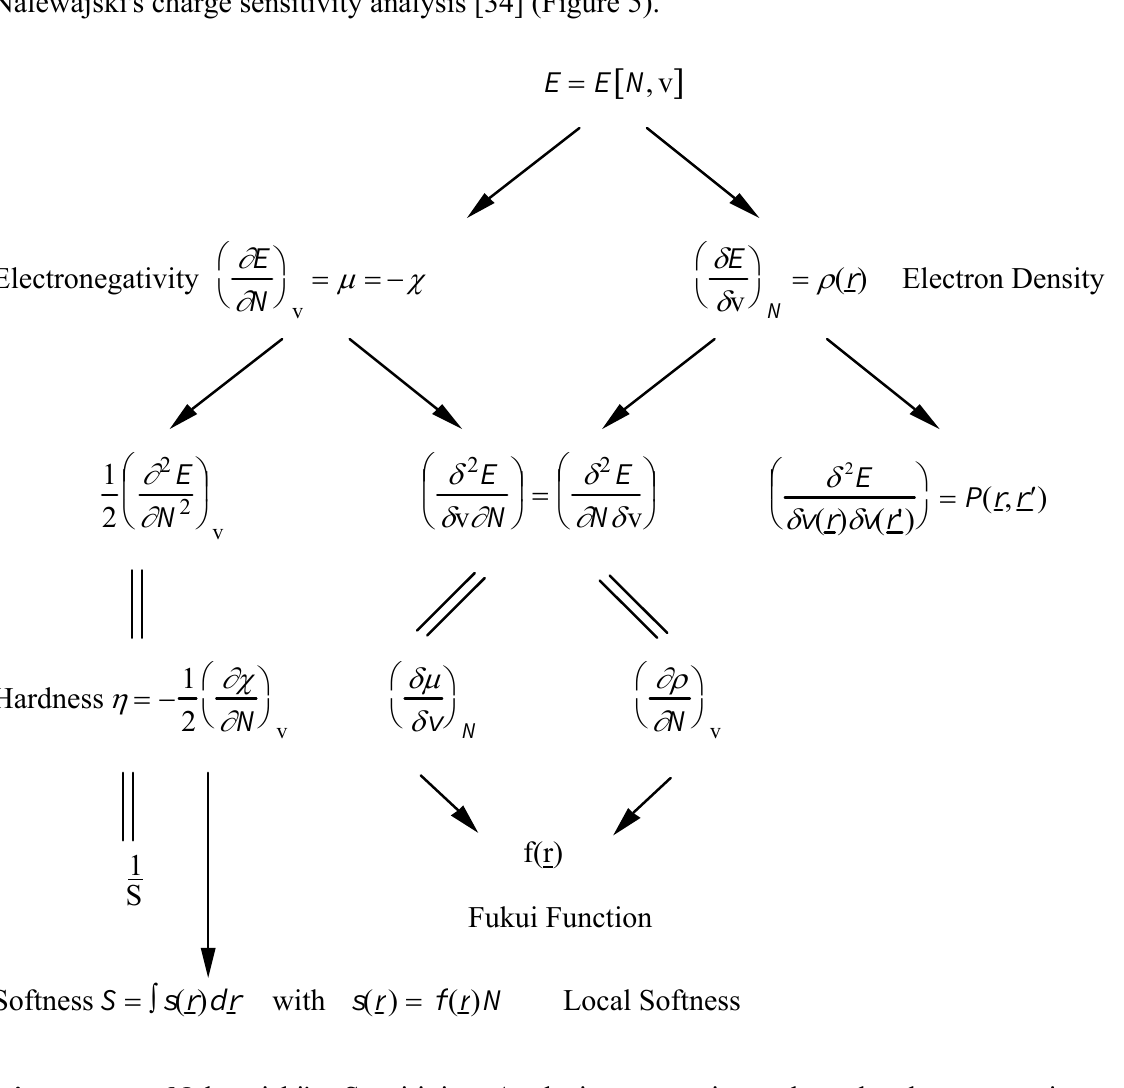
Figure 5 : Nalewajski's Sensitivity Analysis : atomic and molecular properties as energy derivatives with respect to N and